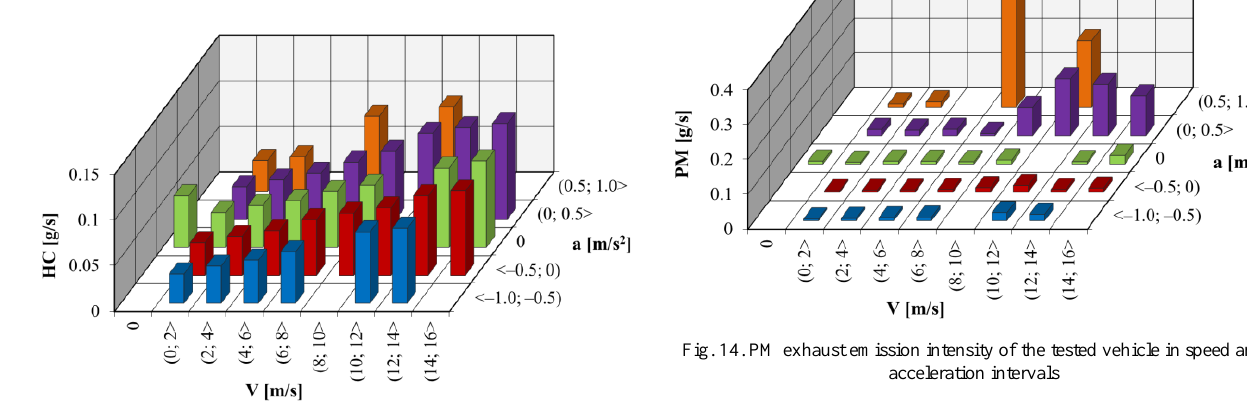
Fig. 12. HC exhaust emission intensity of the tested vehicle in speed and acceleration intervals